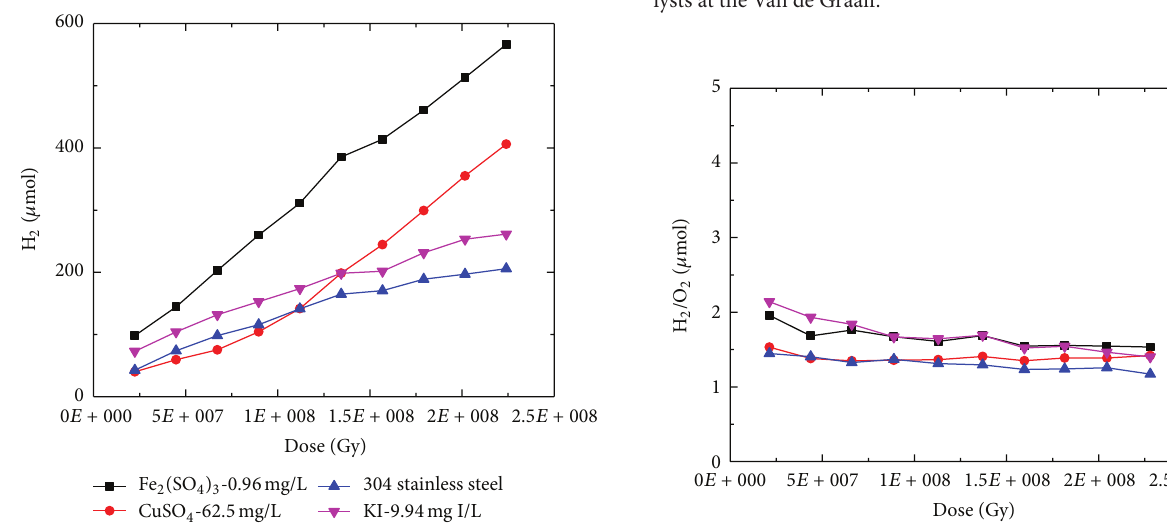
Figure 8: Hydrogen evolution measured during irradiation of 126g-U/L UO 2 SO 4 solutions in the presence of potential peroxide catalysts at the Van de Graaff.